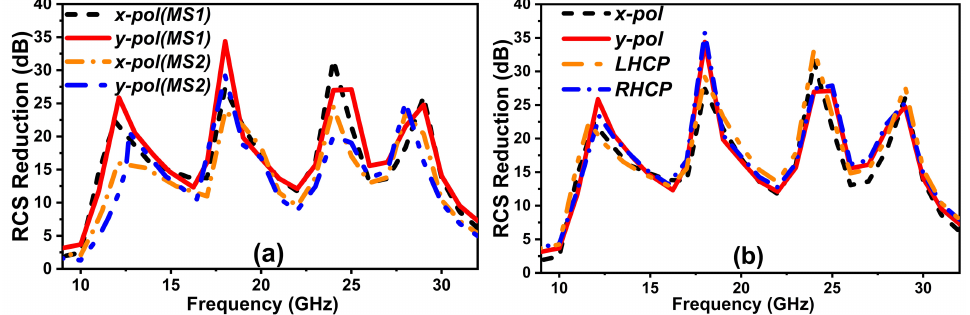
Figure 12. ( a ) Monostatic RCS reduction of MS1 and MS2. ( b ) RCS reduction of MS1 for linear and circular